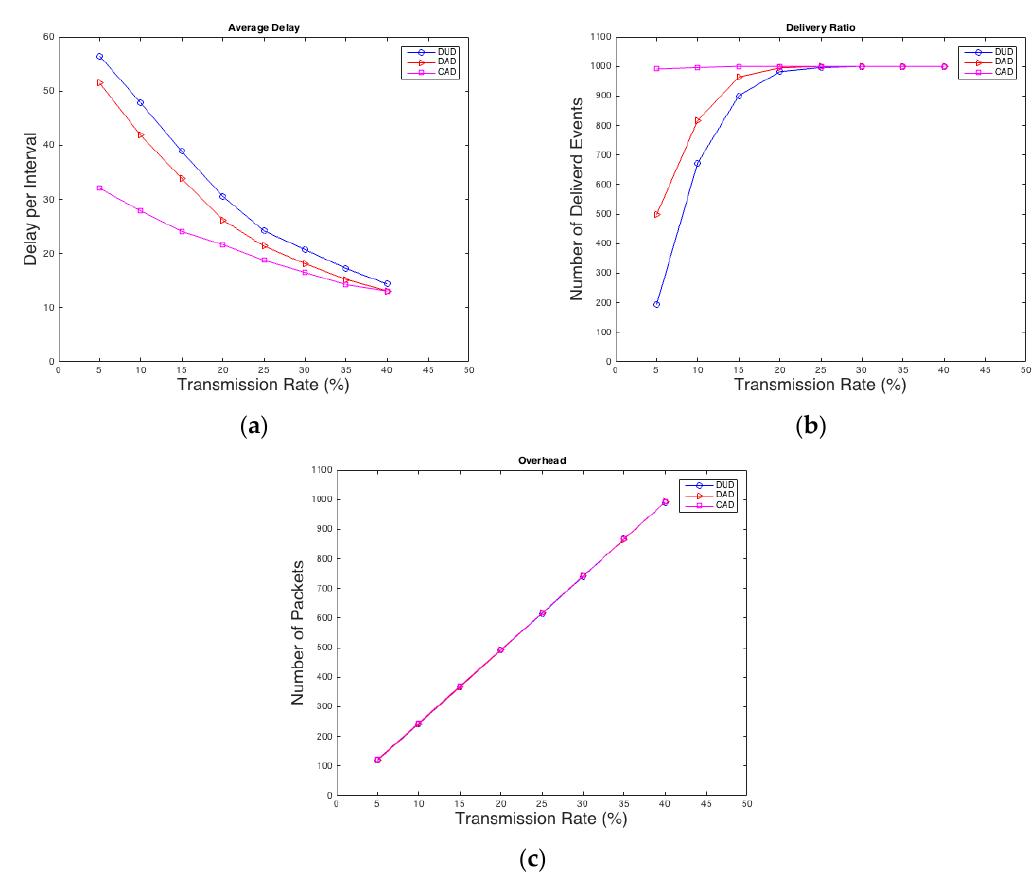
Figure 3. ( a ) Average delay; ( b ) delivery ratio; ( c ) overhead.